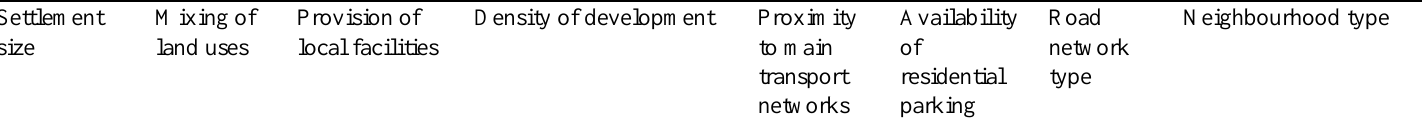
Table 1. Studies Classified According to Land Use Characteristics and Travel